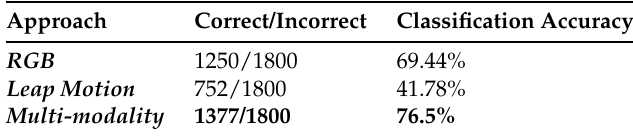
Table 6. Results of the three trained models applied to unseen data.